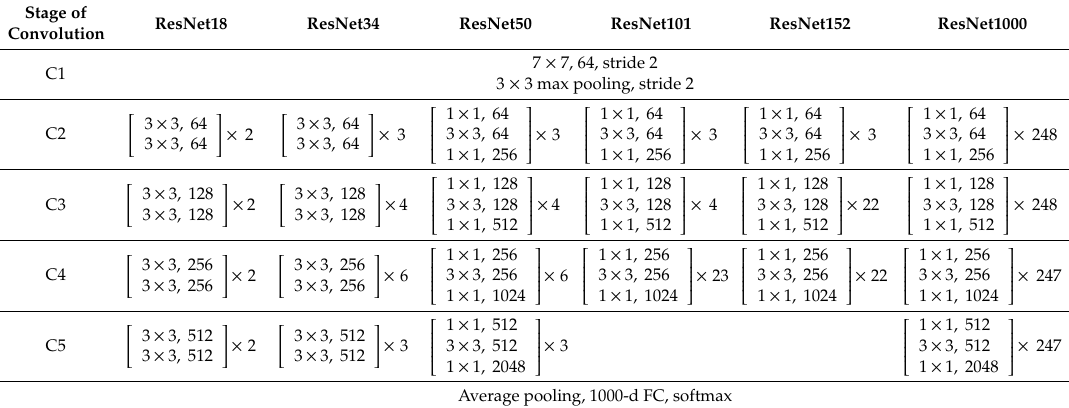
Table 2. Detailed architectures for residual network (ResNet).